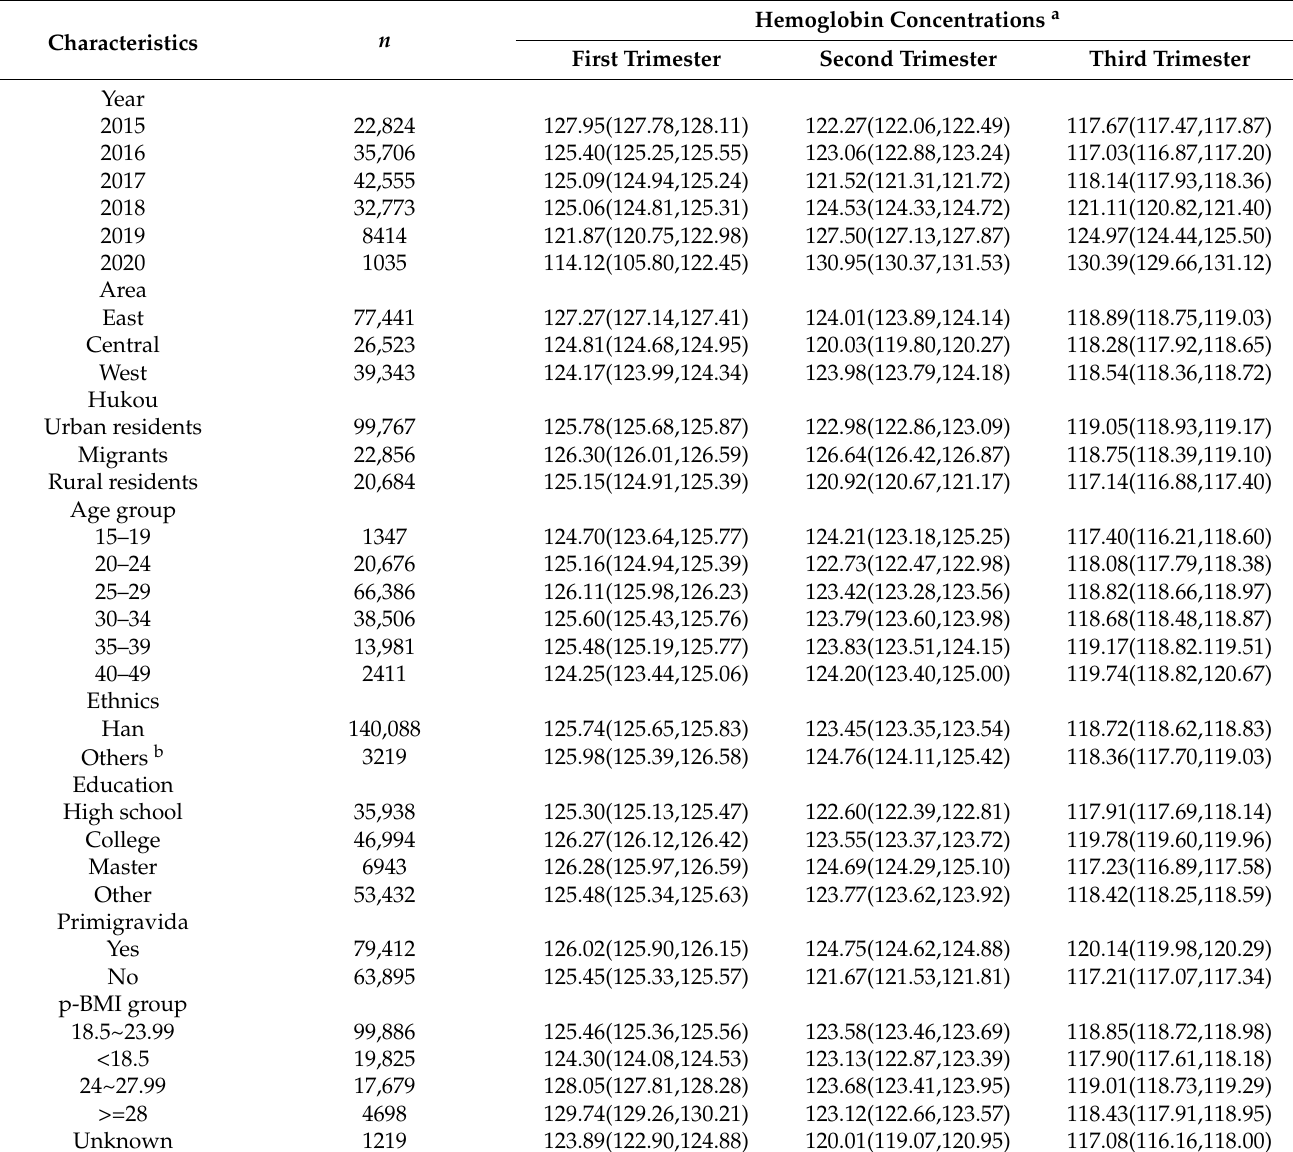
Table 4. The hemoglobin concentration in subgroups according to